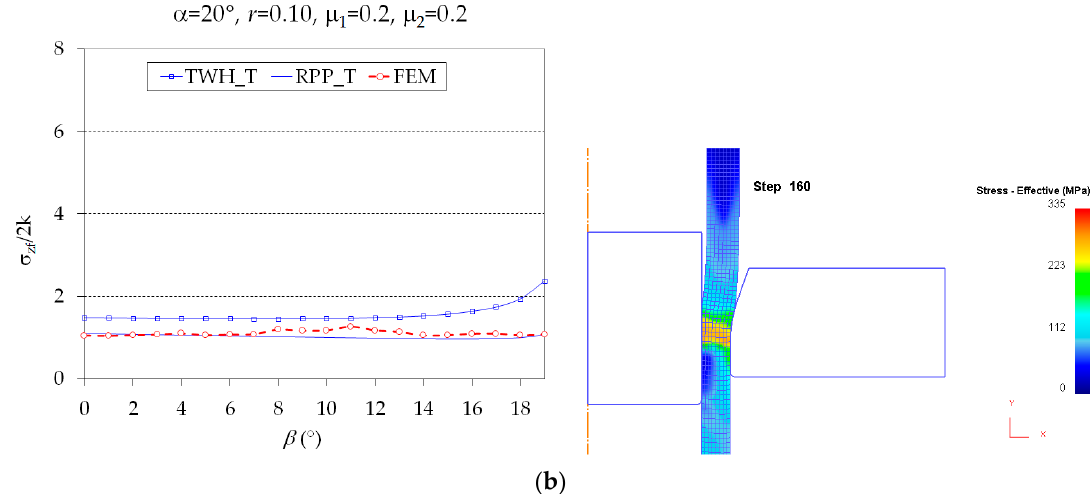
Figure 9. Validation of upper bound method (UBM) model by finite element analysis (FEA) varying other parameters and corresponding effective stress contour diagrams obtained by DEFORM for β = 0 ◦ : ( a ) α = 5 ◦ ; r = 0.40; µ 1 = µ 2 = 0.05; ( b ) α = 20 ◦ ; r = 0.10; µ 1 = µ 2 = 0.20.